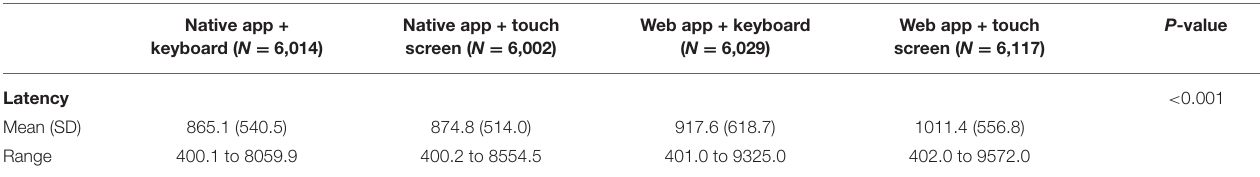
TABLE 4 | Latency value based comparison of app types and input methods. Native app + keyboard ( N =